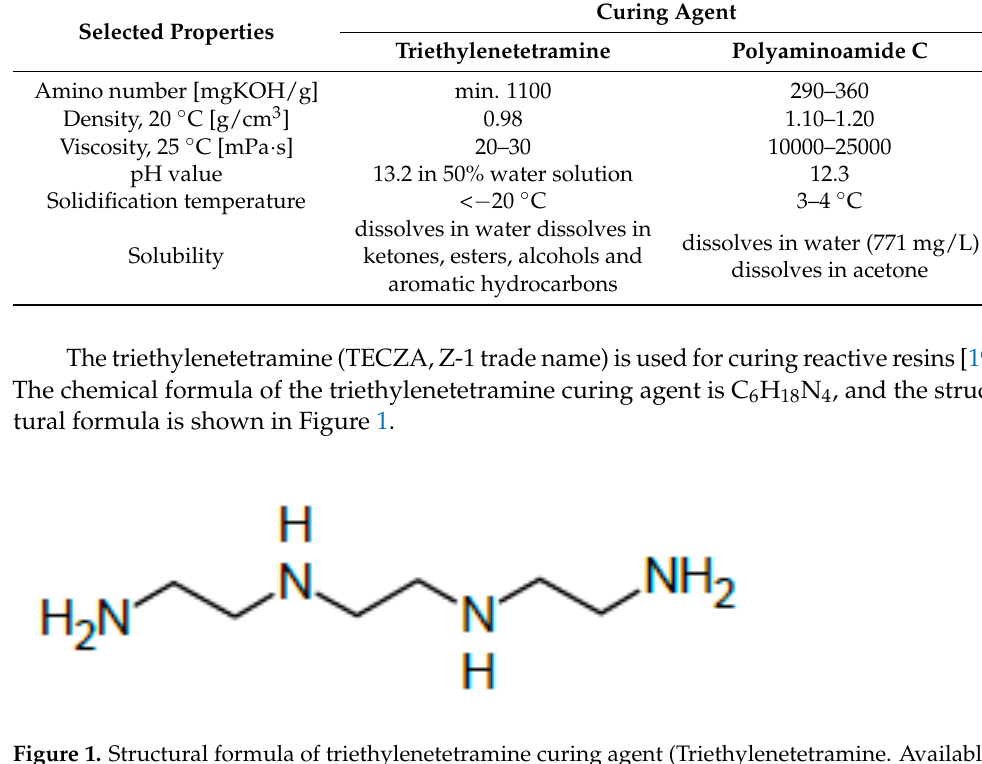
Figure 1. Structural formula of triethylenetetramine curing agent (Triethylenetetramine. Available online: https://pl.qaz.wiki/wiki/Triethylenetetramine (accessed on 9 March 2021)).